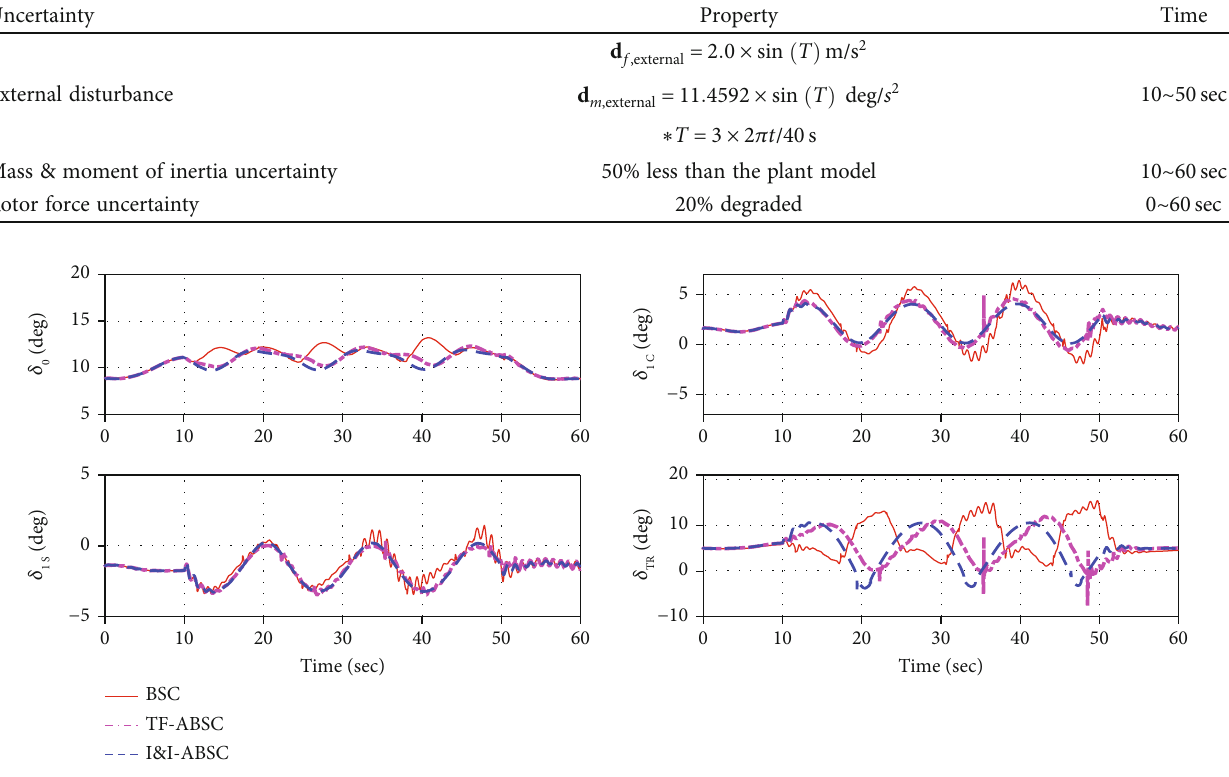
Figure 9: Case B: calculated controls of BSC, TF-ABSC, and